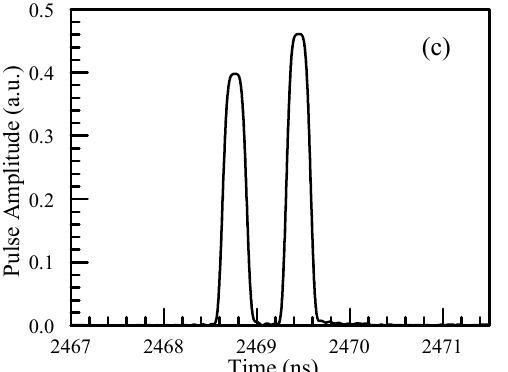
Figure 4. ( a ) The inverse Fourier transform of the real part of CTF measured at 1550 nm; ( b ) the modified CTF defined in Equation (4), CTF’; ( c ) the calculated output pulses for the 500 m PMF.